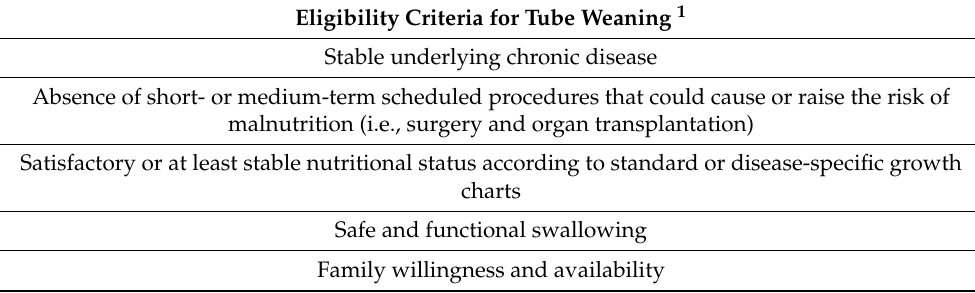
Table 4. Eligibility criteria for tube weaning